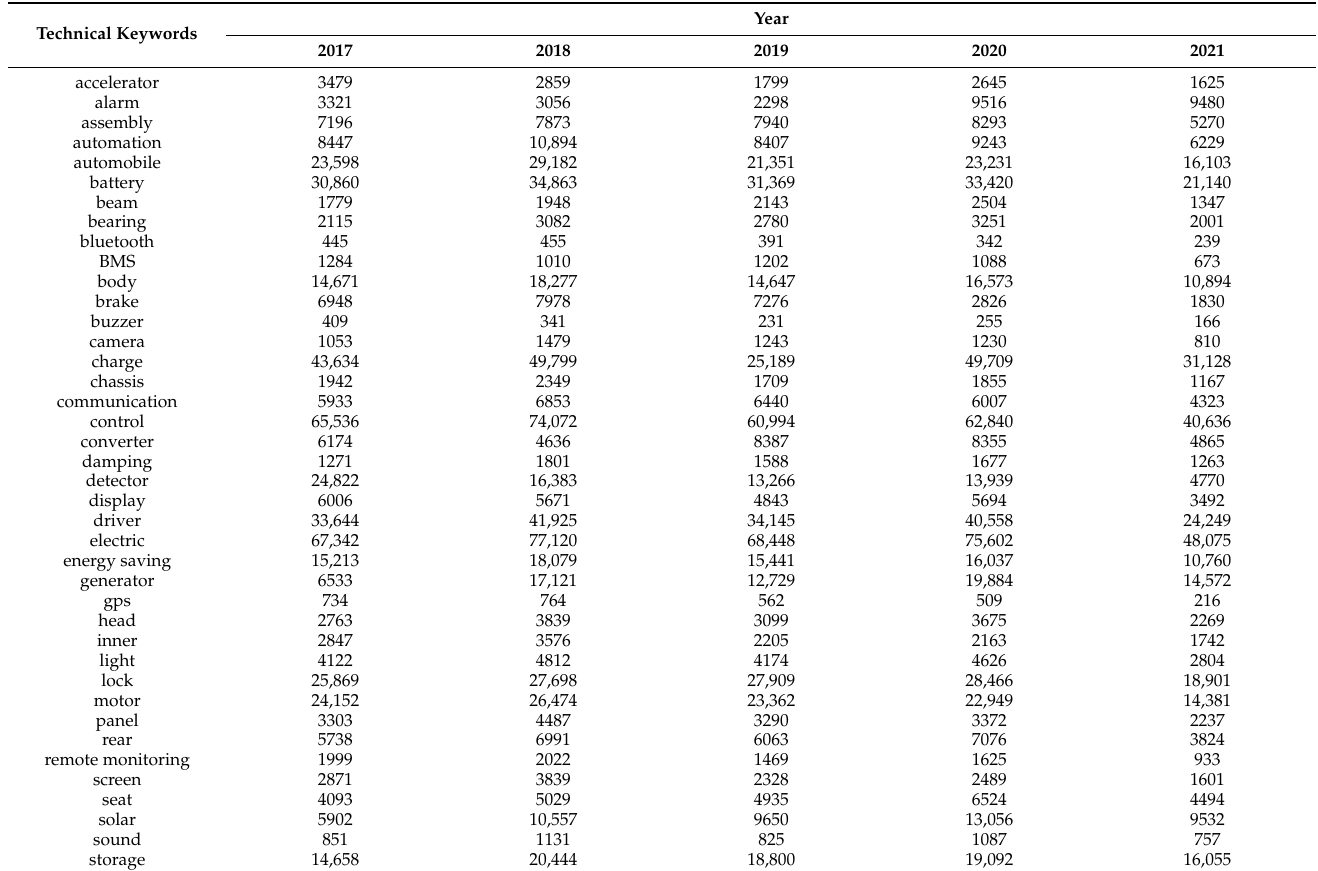
Table A2. Degree centrality of technical keywords in the EVs field in